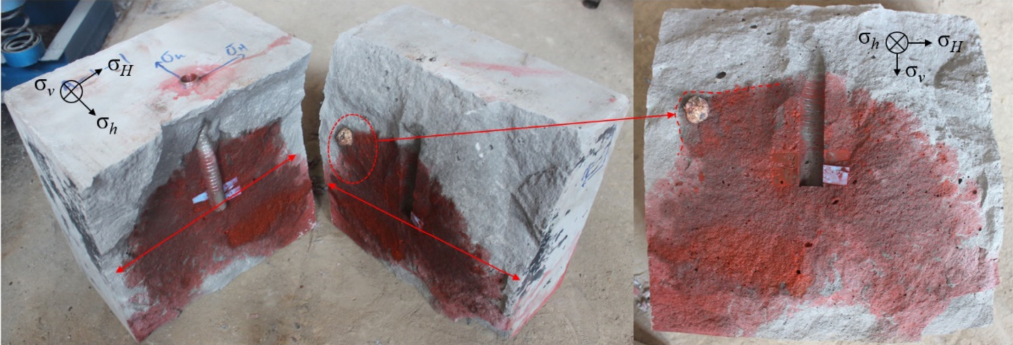
Figure 4. Hydraulic fracture geometry of sample C-2.